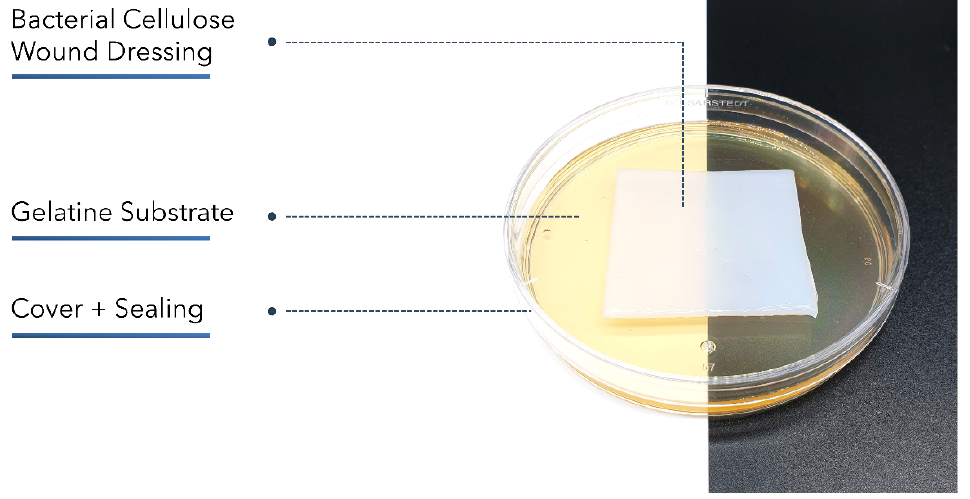
Figure 8. Setup based on EN 13726-1:2002 part 3.4 to compare moisture-donating wound dressings regarding their fluid donation. A gelatin gel with a water content <35% was weighed before and after 48 h of contact with the dressing samples. The petri dish was covered and sealed tightly to prevent evaporation.